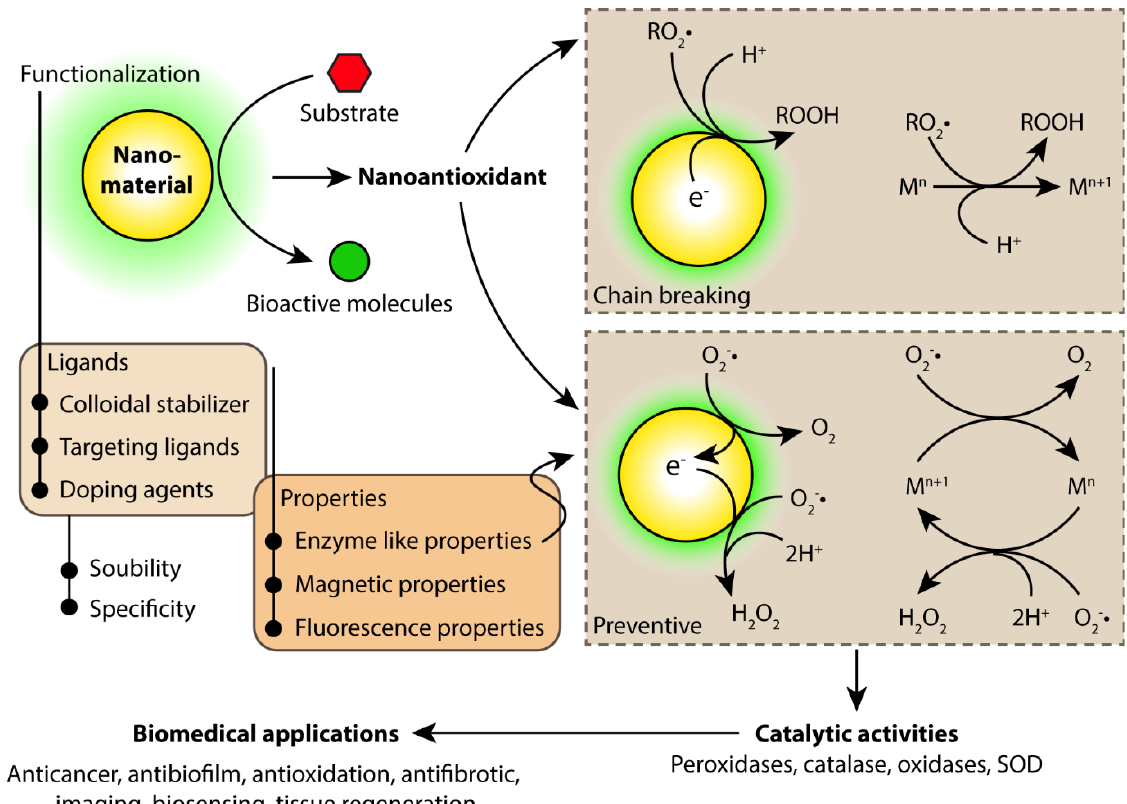
Figure 4: Overview of nanomaterials as antioxidant agents and the effect of surface functionalization. Various types of ligands can be used as functionalizing agent to increase the solubility and specificity towards target organ of the nanomaterials. The ligand functionalization may impart several other interesting physicochemical properties that may useful for biomedical